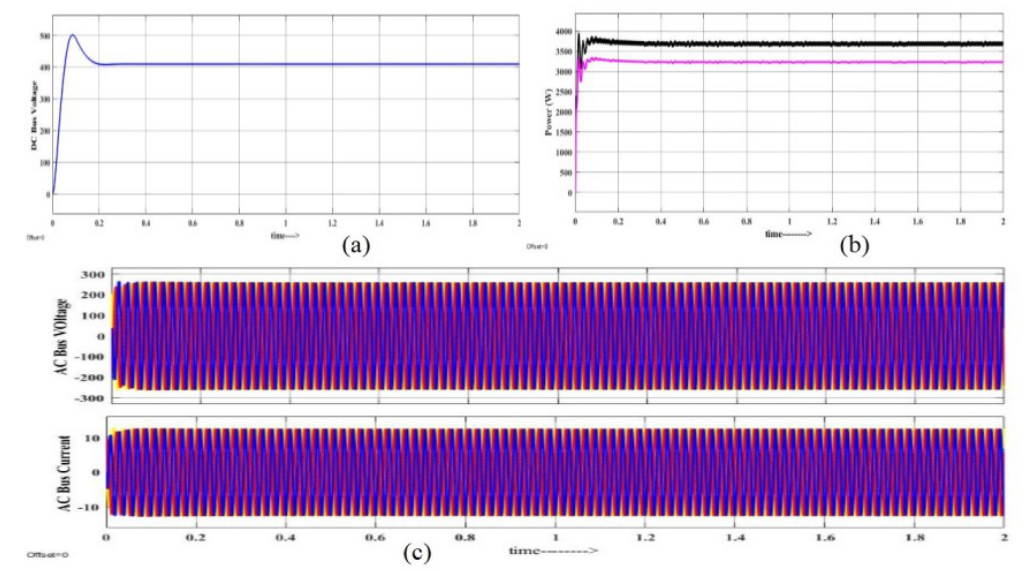
Fig. 6. System Parameters under islanded mode without controller: (a) DC bus voltage, (b) Load Power, (c) AC bus voltage and current